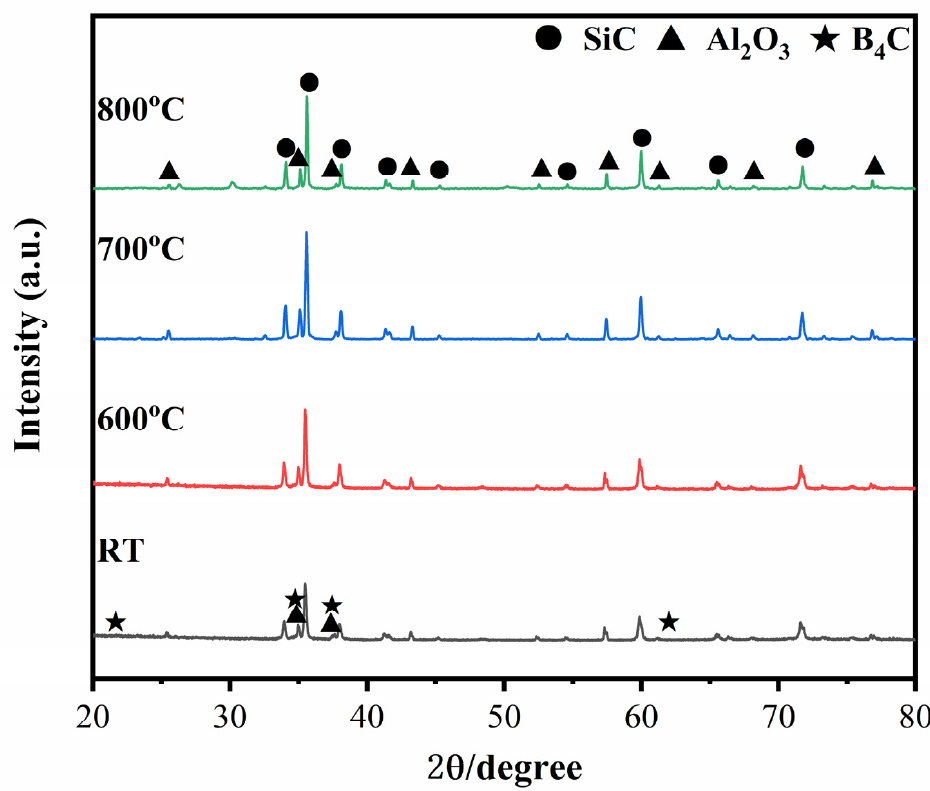
Figure 2. XRD patterns of ceramic composites healing for 60 min at T h = 25 °C, 600 °C, 700 °C and 800 °C.